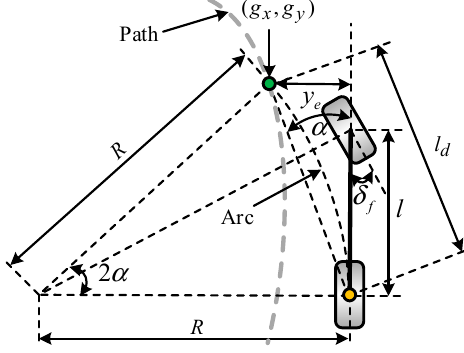
Figure 4. Diagram of the pure pursuit method.